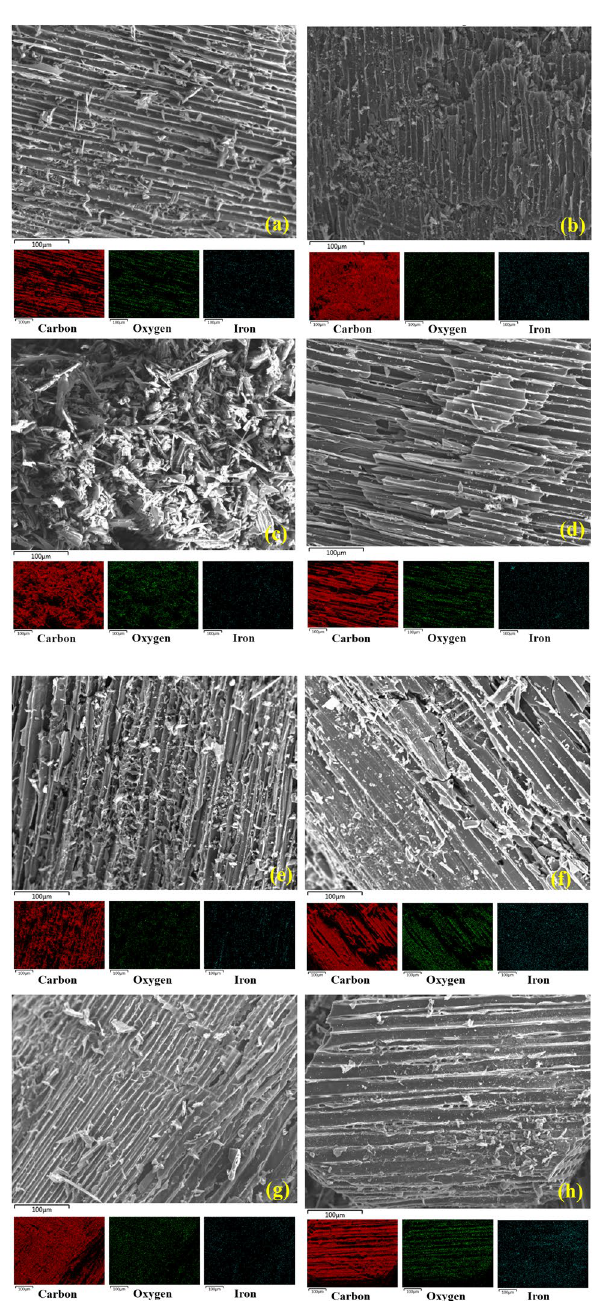
Fig. 4 Scanning electron microscope and EDX mapping images of different ultrasonic pre-treated samples a and b pre and post pyrol- ysis biochar of Fe-UST1 c and d pre and post pyrolysis biochar of Fe-UST2 e and f pre and post pyrolysis biochar of Fe-UST3 g and h pre and post pyrolysis biochar of